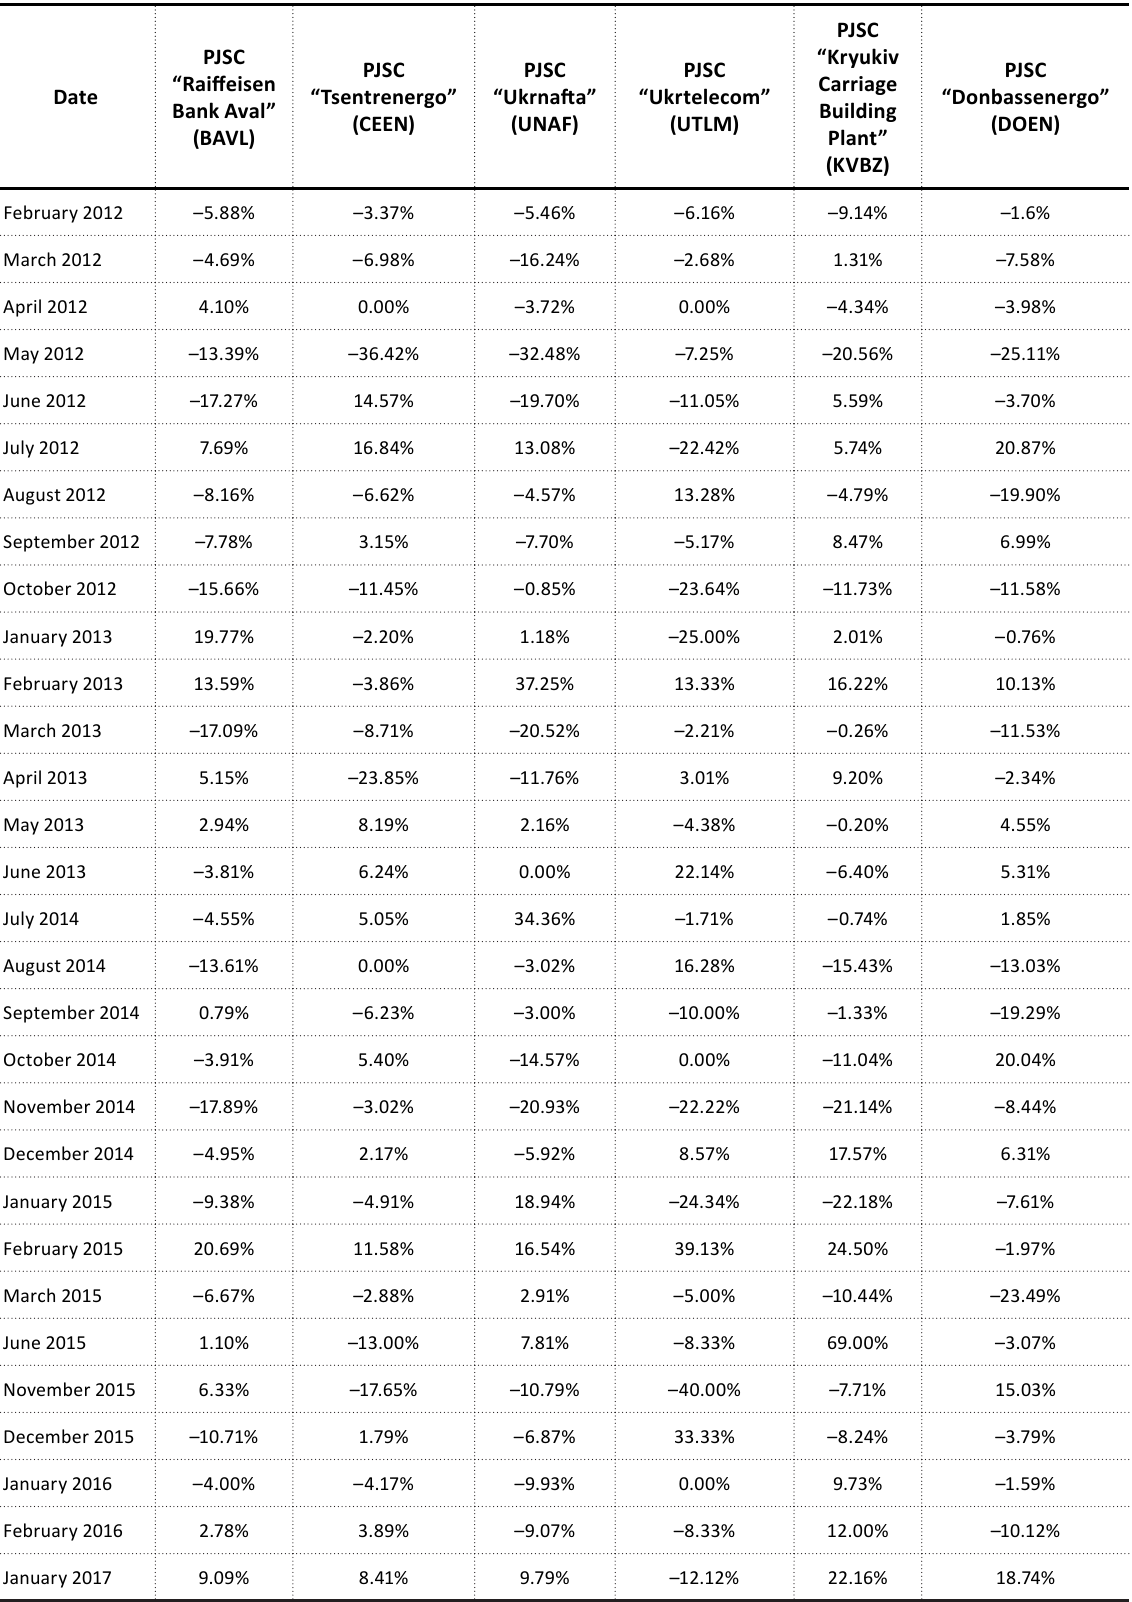
Source: Taken from site